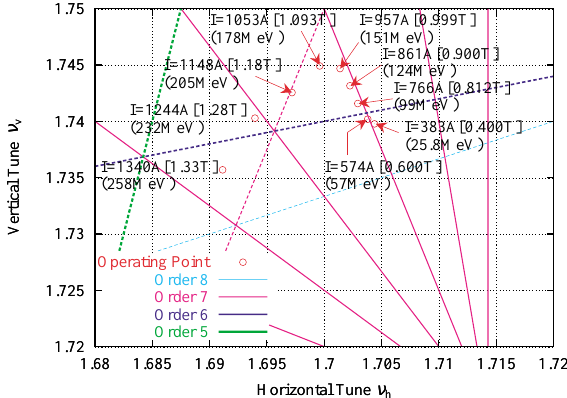
FIG. 7. (Color) Excitation dependence of tune values with reso- nance lines up to the eighth order. The solid lines and the dashed lines show sum and differential resonance lines, respectively. Low order resonance lines up to the fourth do not exist around the operating